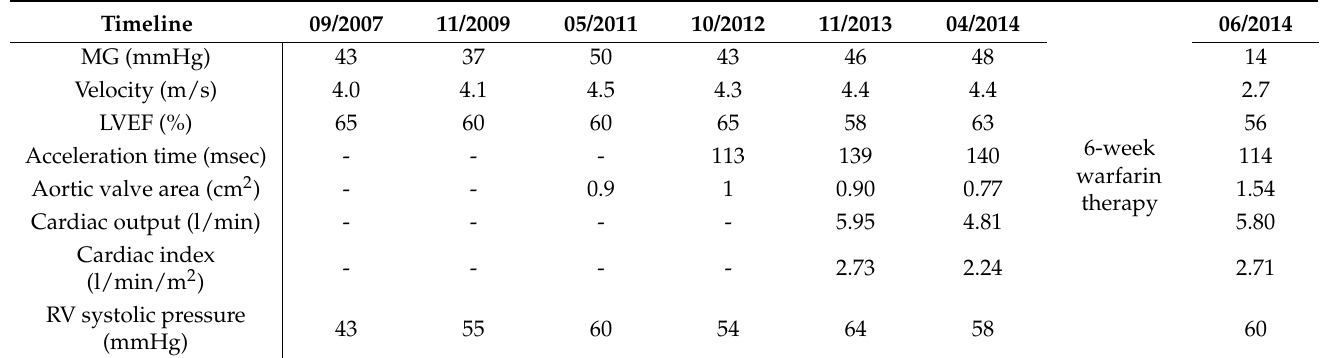
Table 1. Echocardiographic aortic valve parameters over a 7-year period and following a 6-week warfarin